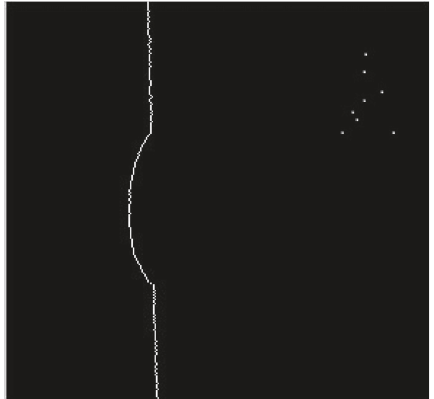
Figure 2: Schematic diagram of experimental laser photography.